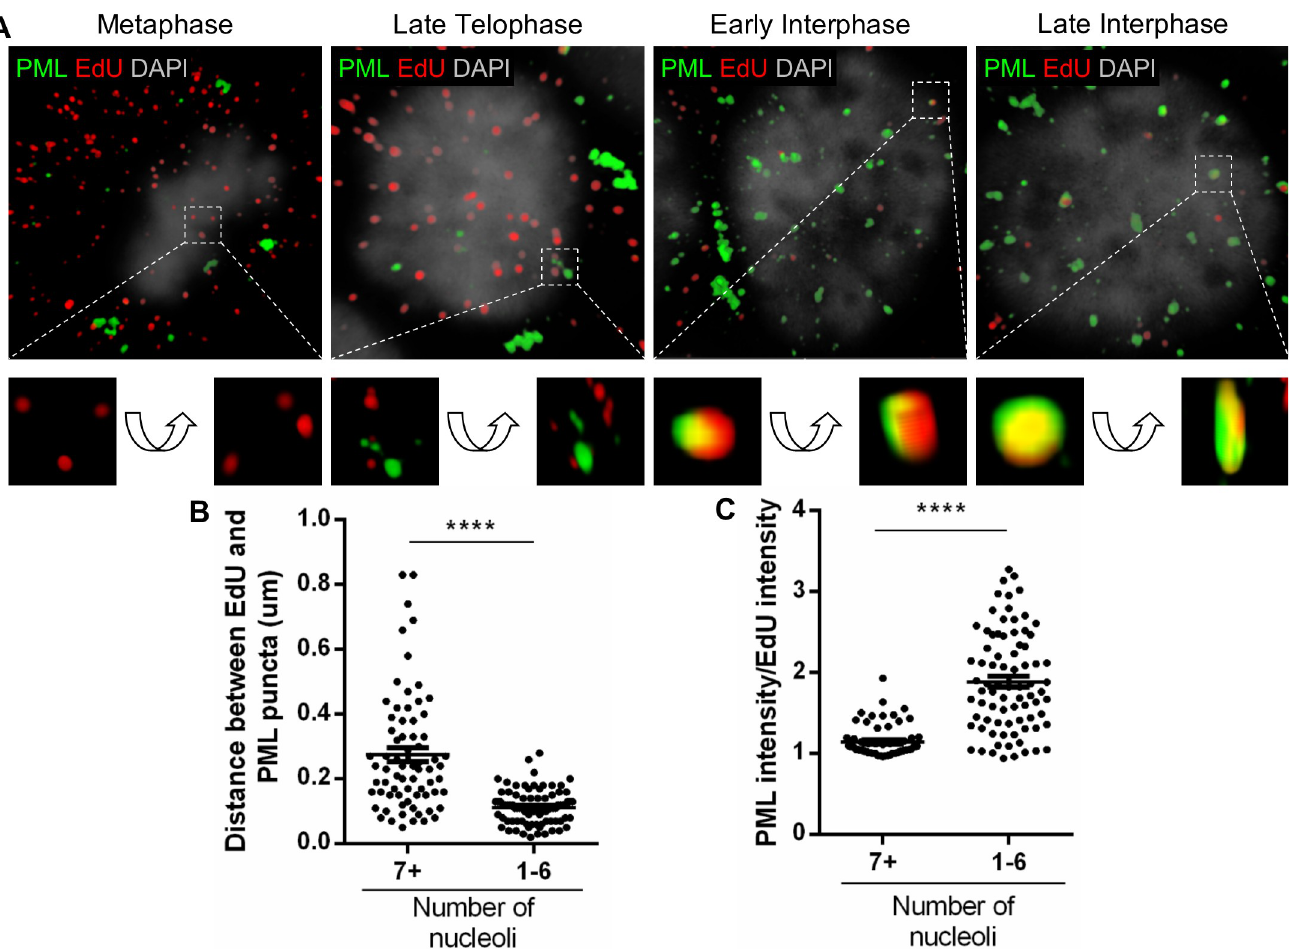
Fig 2. PML protein encompasses incoming viral genomes only after nuclear delivery. HaCaT cells were infected with EdU-labeled PsVs for 24 h, fixed, permeabilized, and treated with Click-iT reaction buffer with AF555 dye to stain EdU-labeled pseudogenomes (red). Next, cells were incubated with mouse anti- PML protein antibody (green) and mounted in DAPI (white). (A) Images show 3D reconstruction of high resolution z-stacks and close-up images were rotated at a 45˚ angle on the x, y, z axes in the 3D-rendered images. (B) Distance ( μ m) between center of EdU and center of PML protein puncta was measured in NIS Elements. (C) PML and EdU mean intensity were measured in NIS Elements, normalized to ROI area, and the ratio was calculated. (B and C) Nucleoli were also counted: 7 + nucleoli corresponds to early interphase, 1–6 to late interphase. Results are shown as average of 2 independent experiments and SEM, with 30–50 cells of each condition (early and late interphase cells) collected in z-stacks spanning the whole nucleus. (B) 7+ nucleoli: 0.275 μ m ± 0.021 μ m; 1–6 nucleoli: 0.113 μ m ± 0.006 μ m. (C) 7+ nucleoli: 1.146 ± 0.025; 1–6 nucleoli: 1.888 ± 0.069. p value was determined using Student’s t -test comparing Early to Late Interphase. ���� : p <